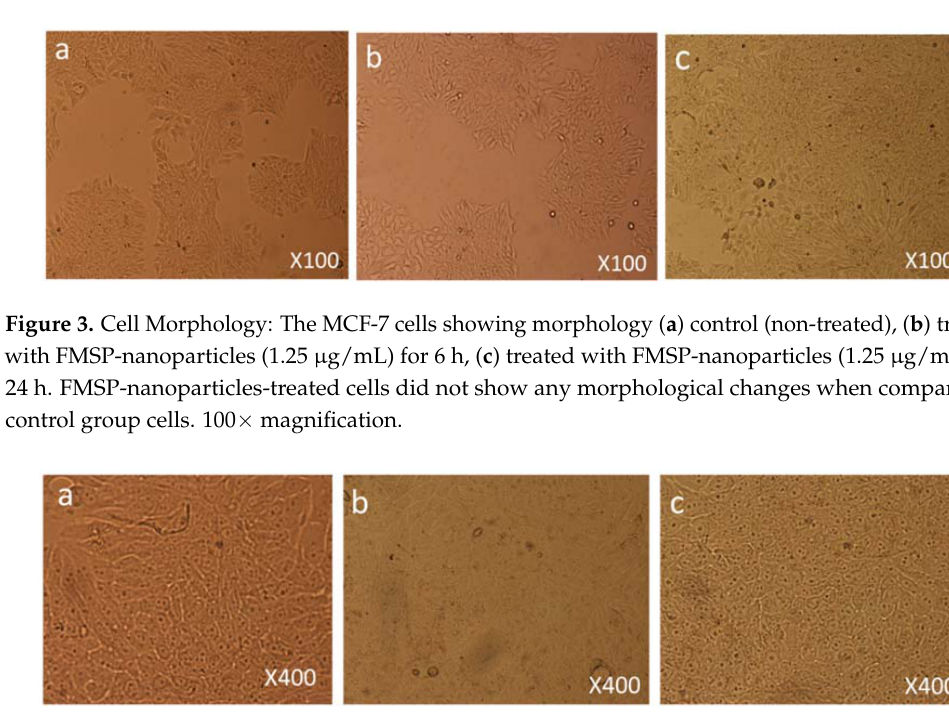
Figure 4. Cell Morphology: The MCF ‐ 7 cells showing morphology ( a ) control (non ‐ treated), ( b ) treated with FMSP ‐ nanoparticles (1.25 μ g/mL) for 6 h, ( c ) treated with FMSP ‐ nanoparticles (1.25 μ g/mL) for 24 h. FMSP ‐ nanoparticles ‐ treated cells did not show any morphological changes when compared to control group cells. 400× magnification.